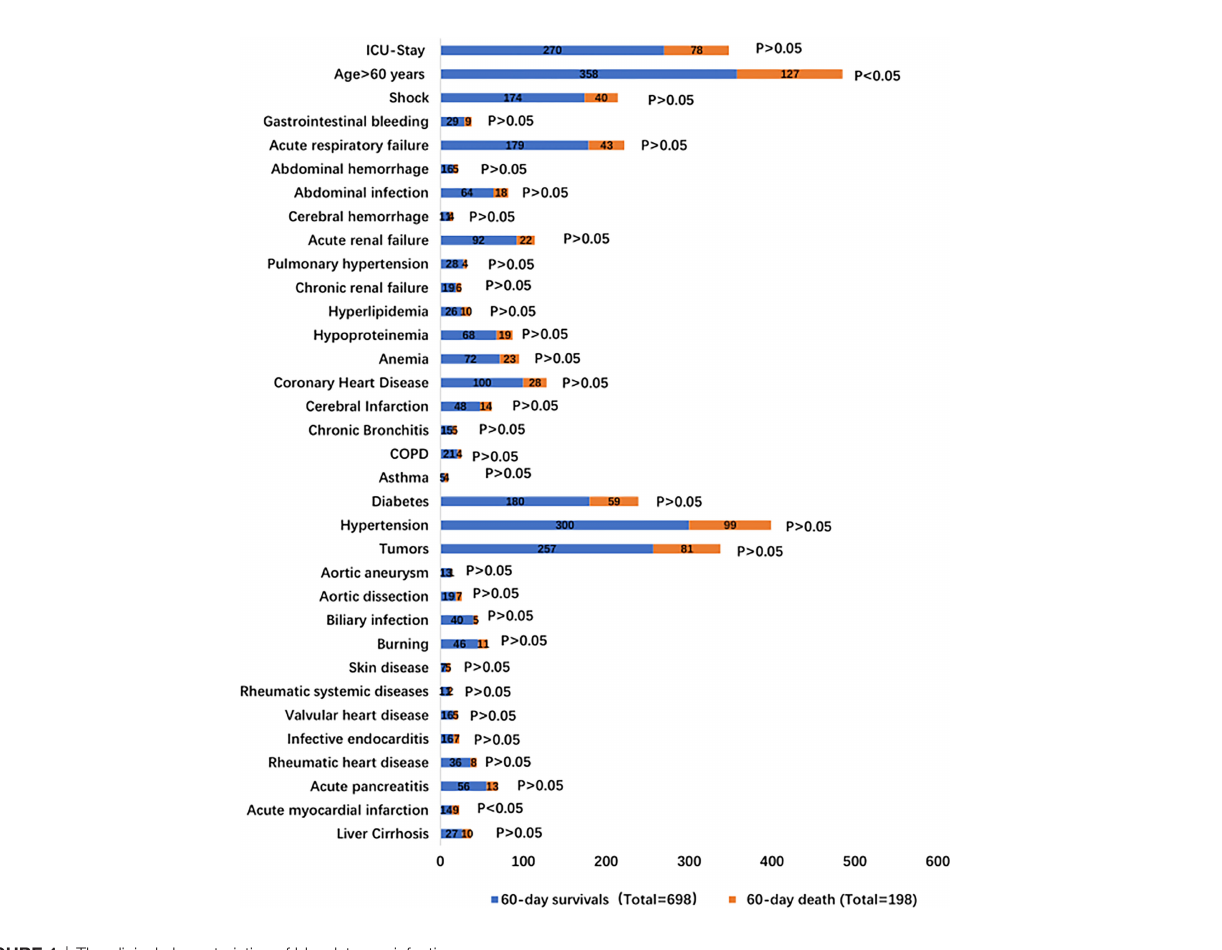
FIGURE 1 | The clinical characteristics of bloodstream